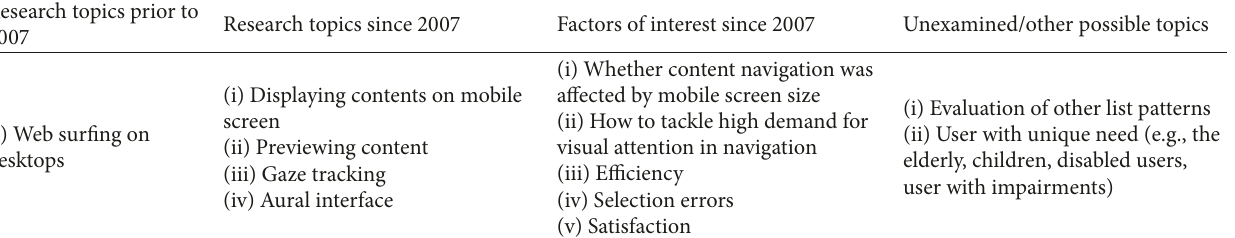
Table 9: Navigation research.